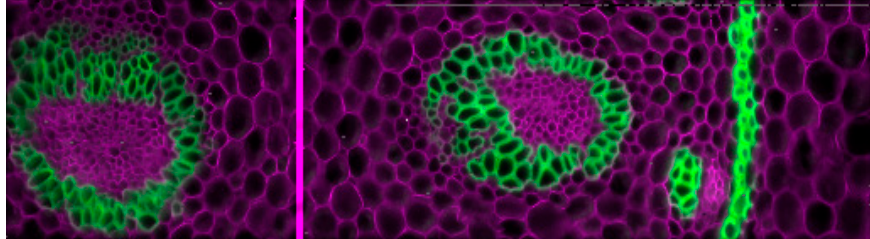
Figure 14. Composite fluorescence image of a thin slice of a plant root stained with a mixture of fluorescent dyes. The picture was obtained with two 20 nm interference filters centered at 530 and 640 nm, respectively. The dead column in the image is due to a false connection between the imager and the FPGA.